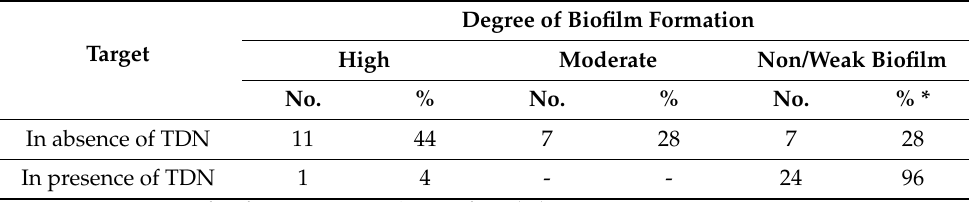
Table 5. Degree of biofilm formation in absence and presence of TDN among 25 MDR P. aeruginosa isolates.